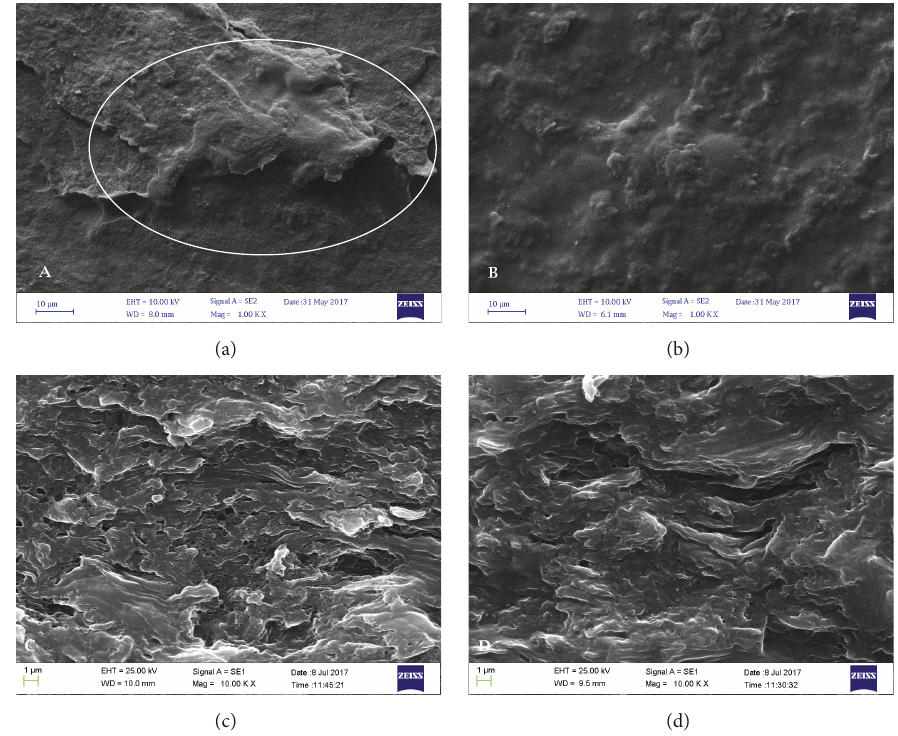
Figure 2: FE-SEM images taken from surface of OD (a) and ID (b) films and from transversal sections of OD (c) and ID (d) films. On image (a) a circle is highlighting the unevenness of the surface compared to the more uniform surface shown on image (b).